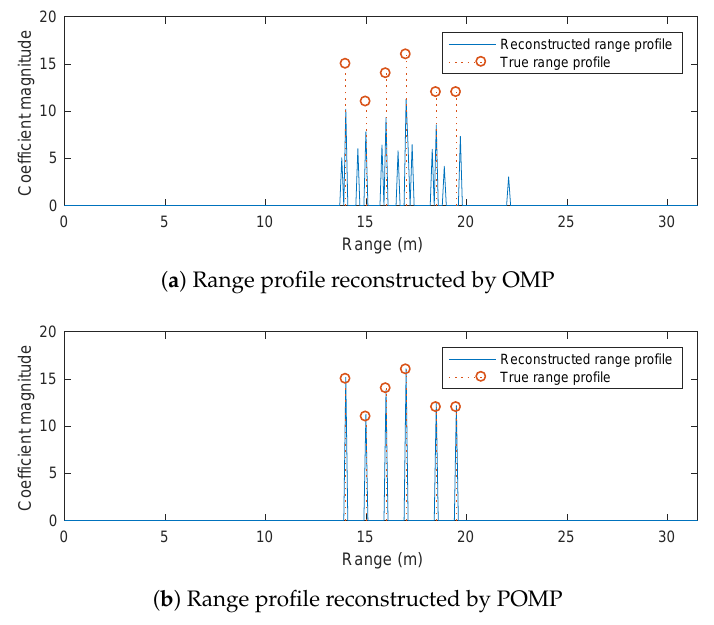
Figure 9. Performance comparison between OMP and POMP for Simulation Scenario 2 (with four